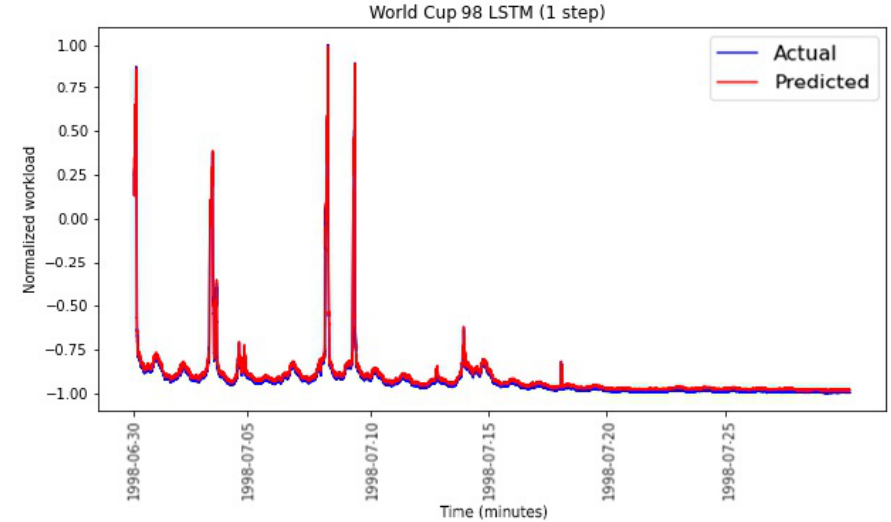
Figure 11. Forward LSTM with one-step prediction on the testing set.